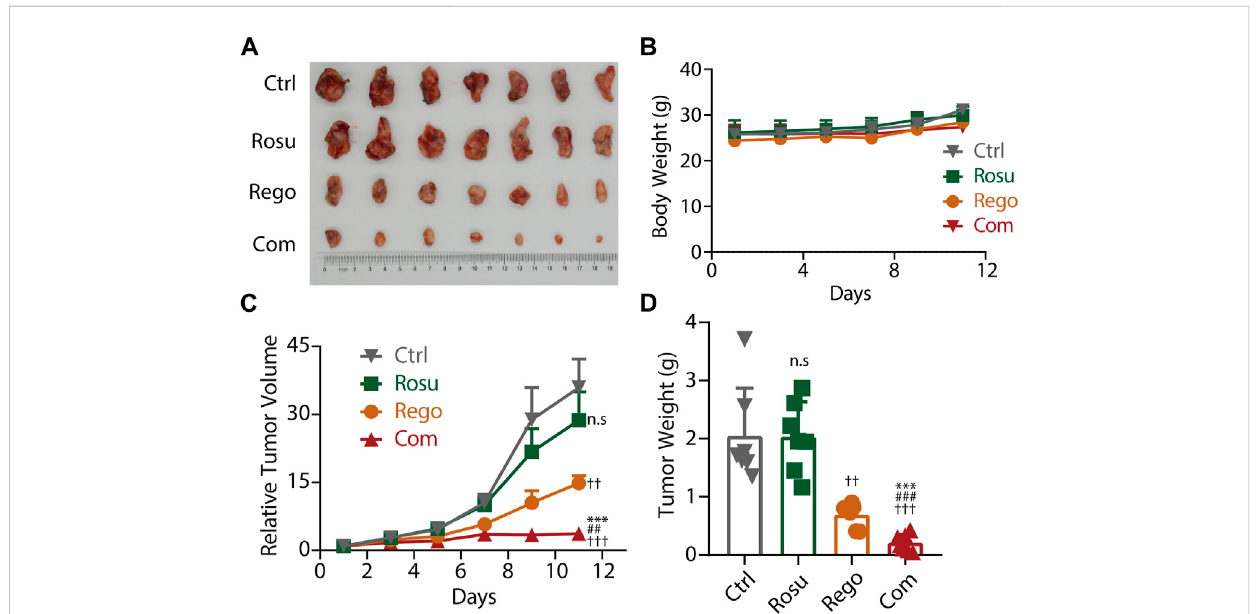
FIGURE 4 Rosuvastatin signi fi cantly promotedthe antitumoreffects of regorafenib on colorectalcancer in vivo . (A) Representative tumor photograph of each group. (B) Body weight of mice in each group. (C) Relative tumor volume of each group. (D) Tumor weight of each group at the endpoint of experiment. C57BL/6 mice accepted subcutaneous injection of MC38 cells. When MC38 tumors grew up to ~70 mm 3 , tumor-bearing mice were randomized into four groups (n = 7/group), guaranteeing the difference in mean tumor volume between groups less than 1 mm 3 . Each group mice accepted intragastric administration of saline, regorafenib (10 mg/kg/day), rosuvastatin (50 mg/kg/day) and combination treatment, respectively. Tumor volume andbodyweightwererecordedevery2 days.Thequantitativedataarepresentedasmean±SEM.n.s,nosense; †† /##, p < 0.01; ††† /###/***, p < 0.001( † : vs . saline group, *: vs . Regorafenib group; #: vs . Rosuvastatin group). Rosu: Rosuvastatin; Rego: regorafenib; Com: